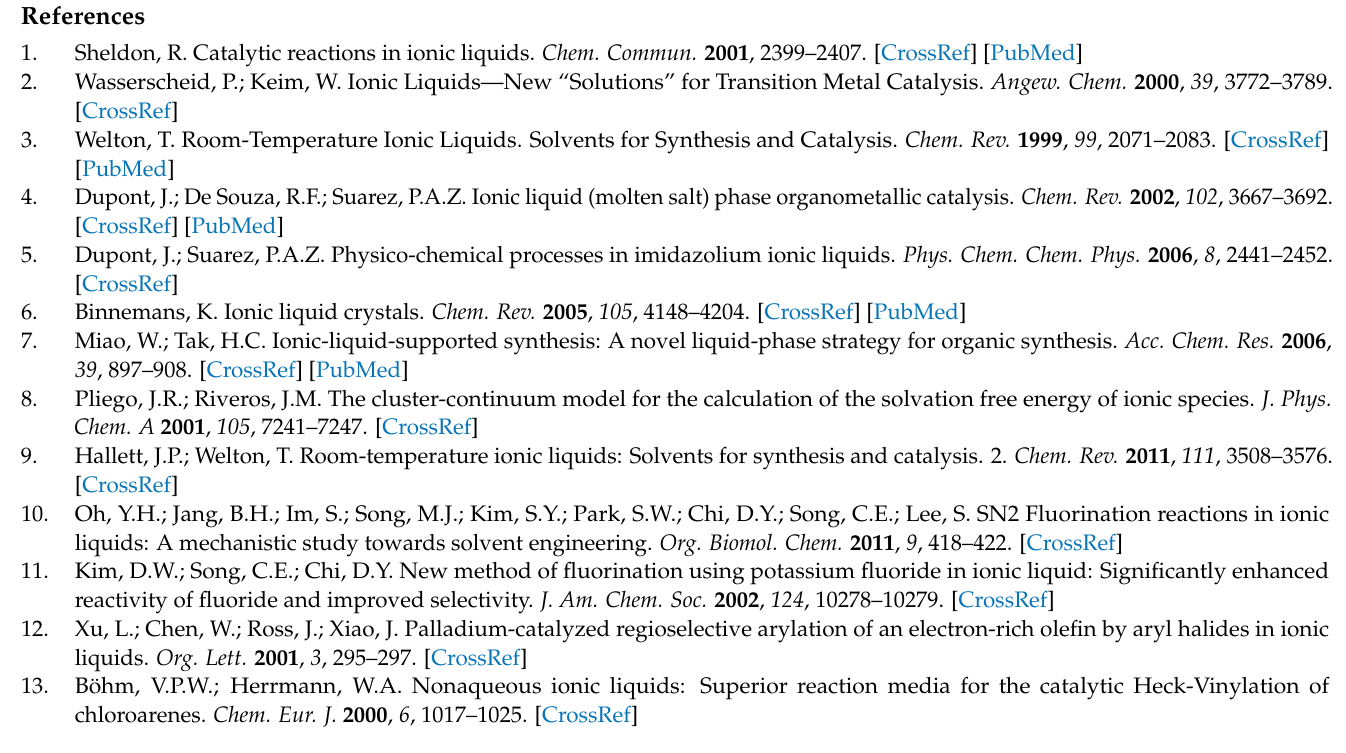
Figure S5. Structures of pre- and post- reaction complexes for S N 2 fluorination in [bmim]PF 6 ,